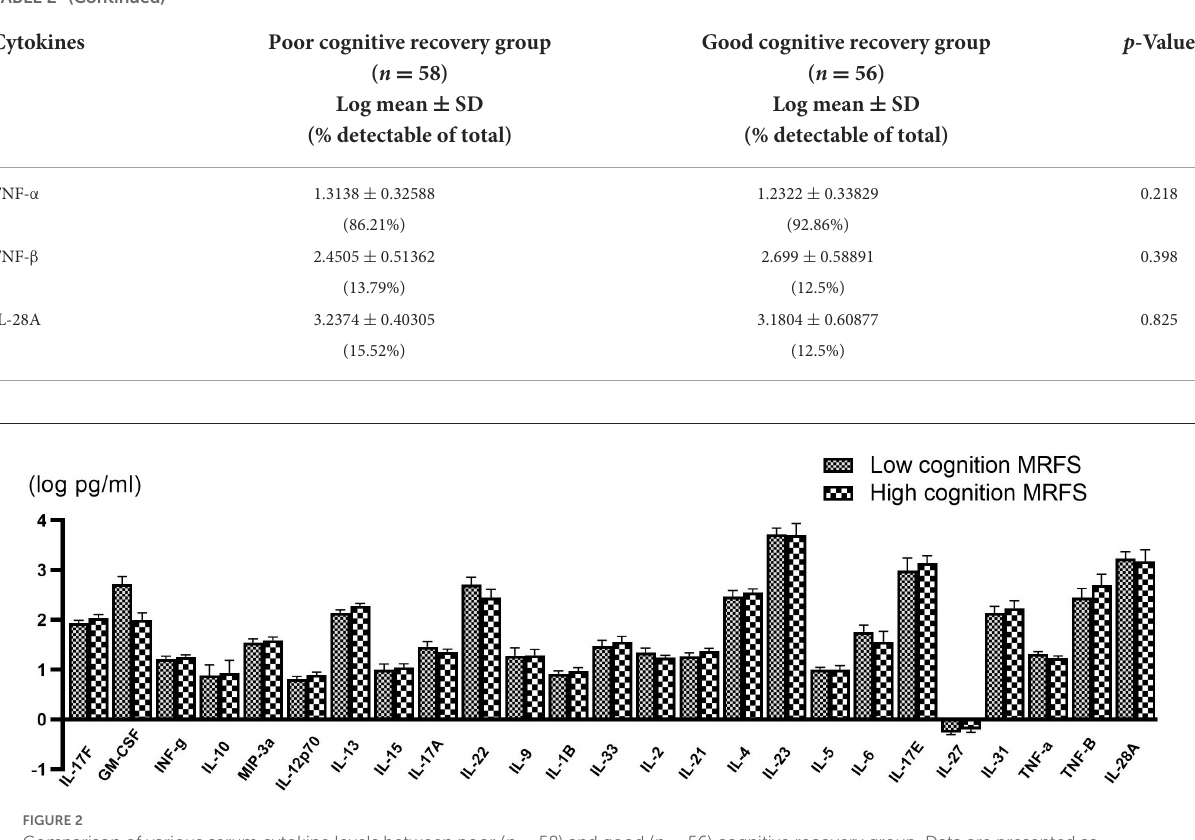
among IL-6, IL-13, and IL-21. These are in concordance with the heatmap